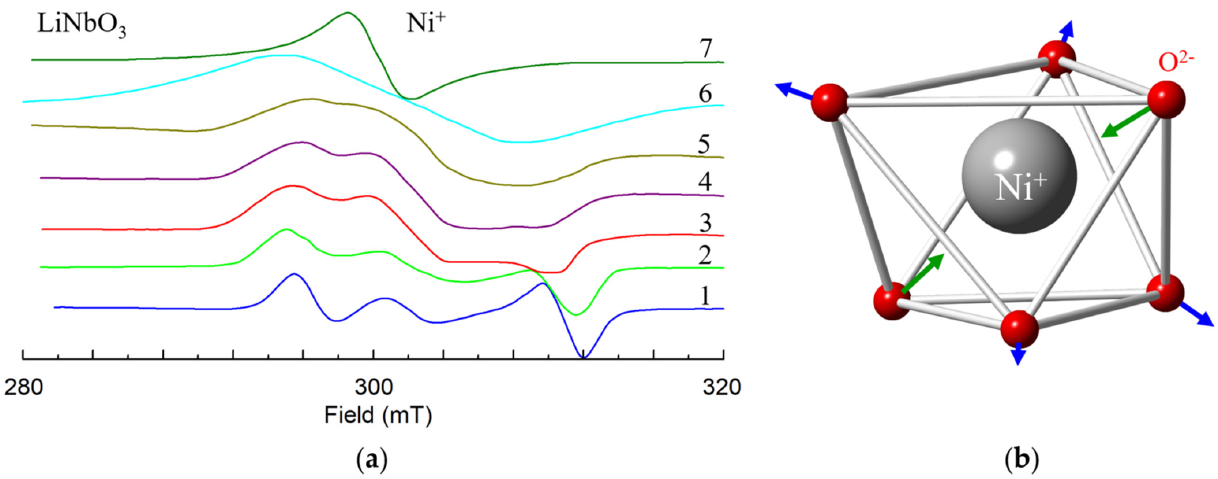
Figure 9. ( a ) X-band EPR spectra of Ni + in LiNbO 3 at θ = 25 deg in zy plane at various temperatures T : 1–40 K, 2–90 K, 3–151 K, 4–206 K, 5–244 K, 6–300 K. The spectrum 7 was measured at θ = 0 deg, T = 300 K. ( b ) Distortion of oxygen octahedron due to the Jahn-Teller effect.